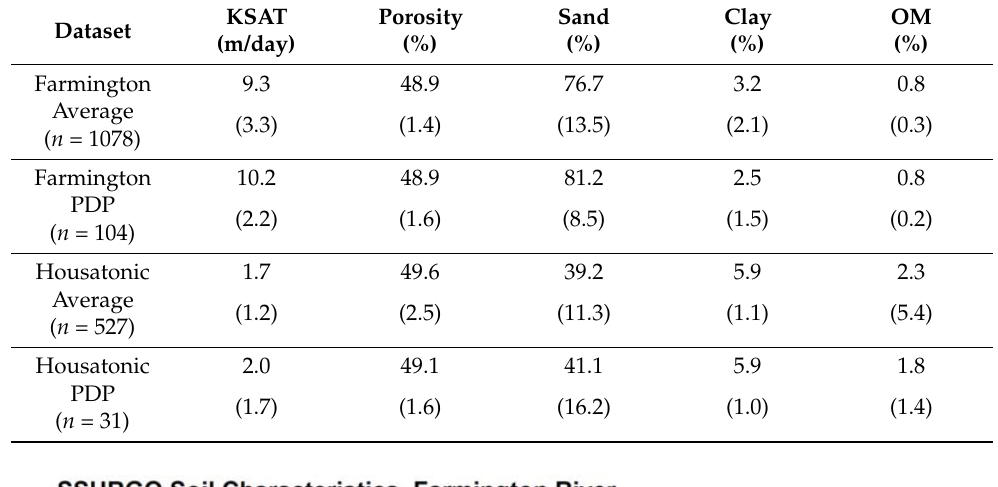
Table 1. Mean (standard deviation) of SSURGO parameters extracted for the riverbank of the study reaches along the entire riverbank (average) and for PDP locations (PDP). OM, organic matter.